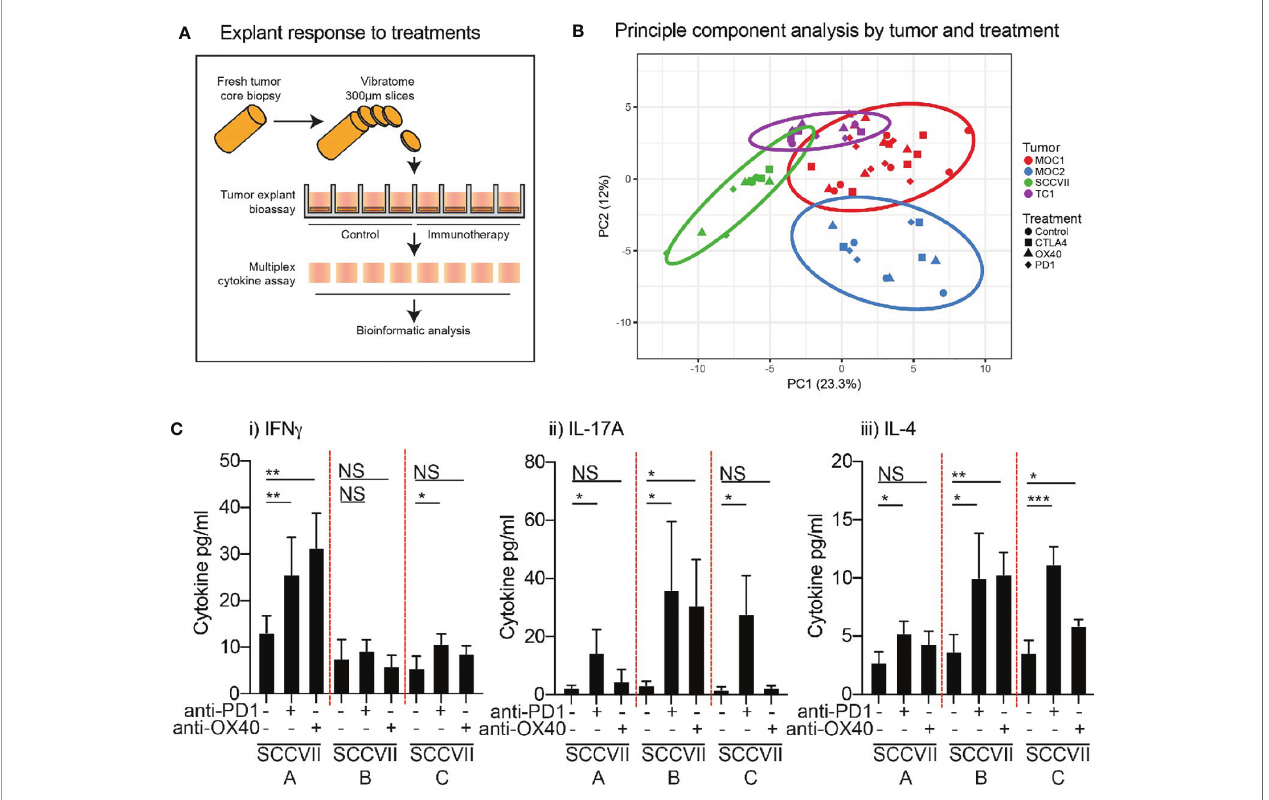
FIGURE 5 | Effect of immunotherapy treatment on cytokine and chemokine secretion from tumor explants. (A) Outline of treatment method using intact tumor explants treated ex-vivo with candidate immunotherapies. (B) Cytokine and chemokine secretion detected by multiplex assay was evaluated by principal component analysis to identify potential distinguishing features. Colors show explants from a speci fi c tumor type. Shapes show different treatments. (C) The response of individual SCC-VII tumor explants to treatment with anti-PD1 or anti-OX40 showing secretion of i) IFNg, ii) IL-17A, iii) IL-4. Graphs show mean and SD expression across replicate explants from individual tumors. Key: NS, not signi fi cant. *p<0.05; **p<0.01;